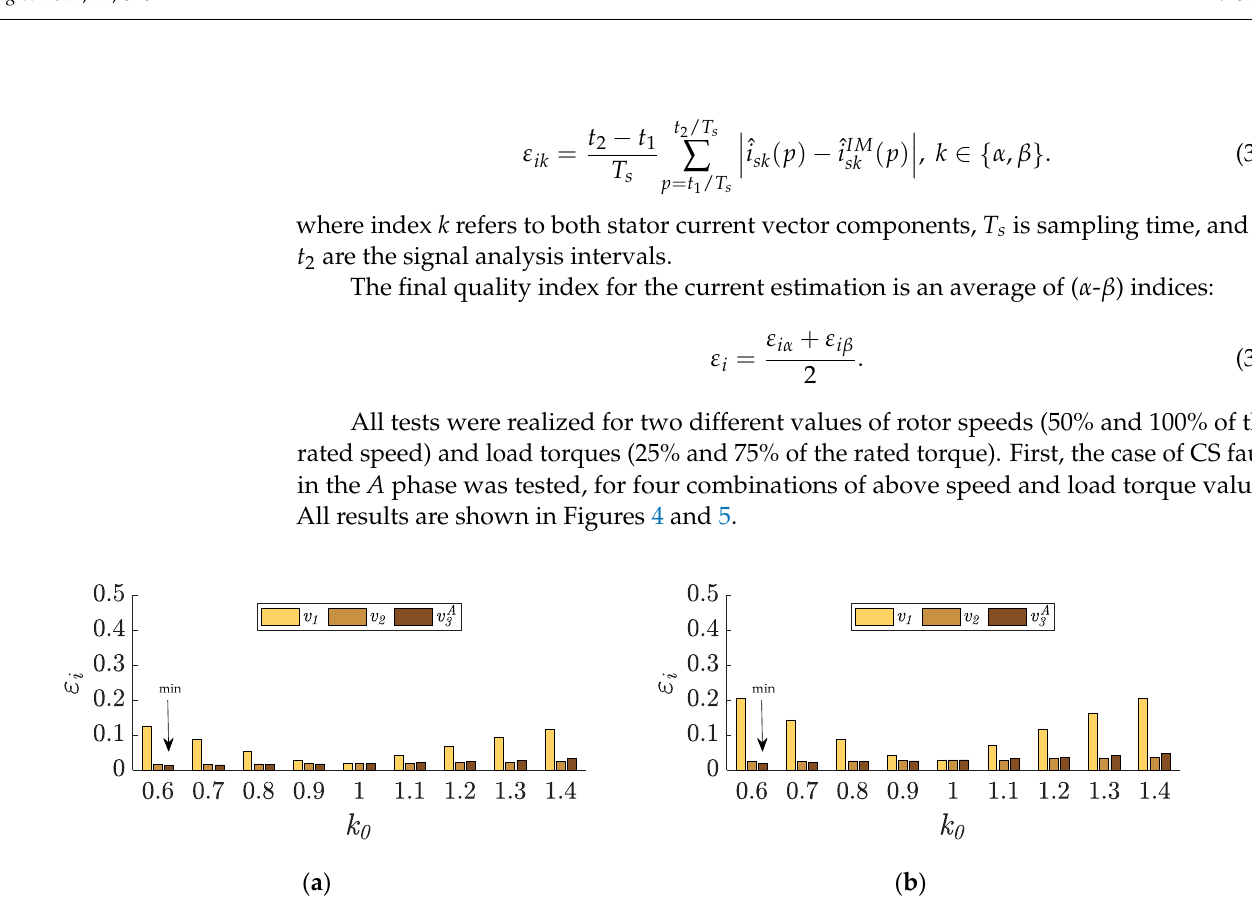
Table 1. Assumed inaccuracy of the IM parameters used in LO model.